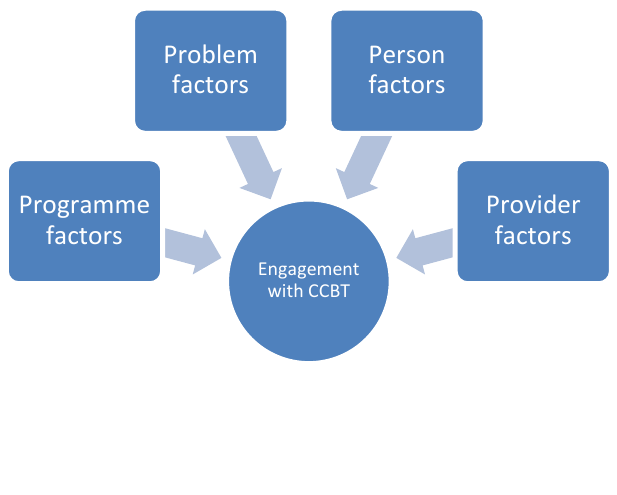
Figure 2. Four Ps model of engagement with